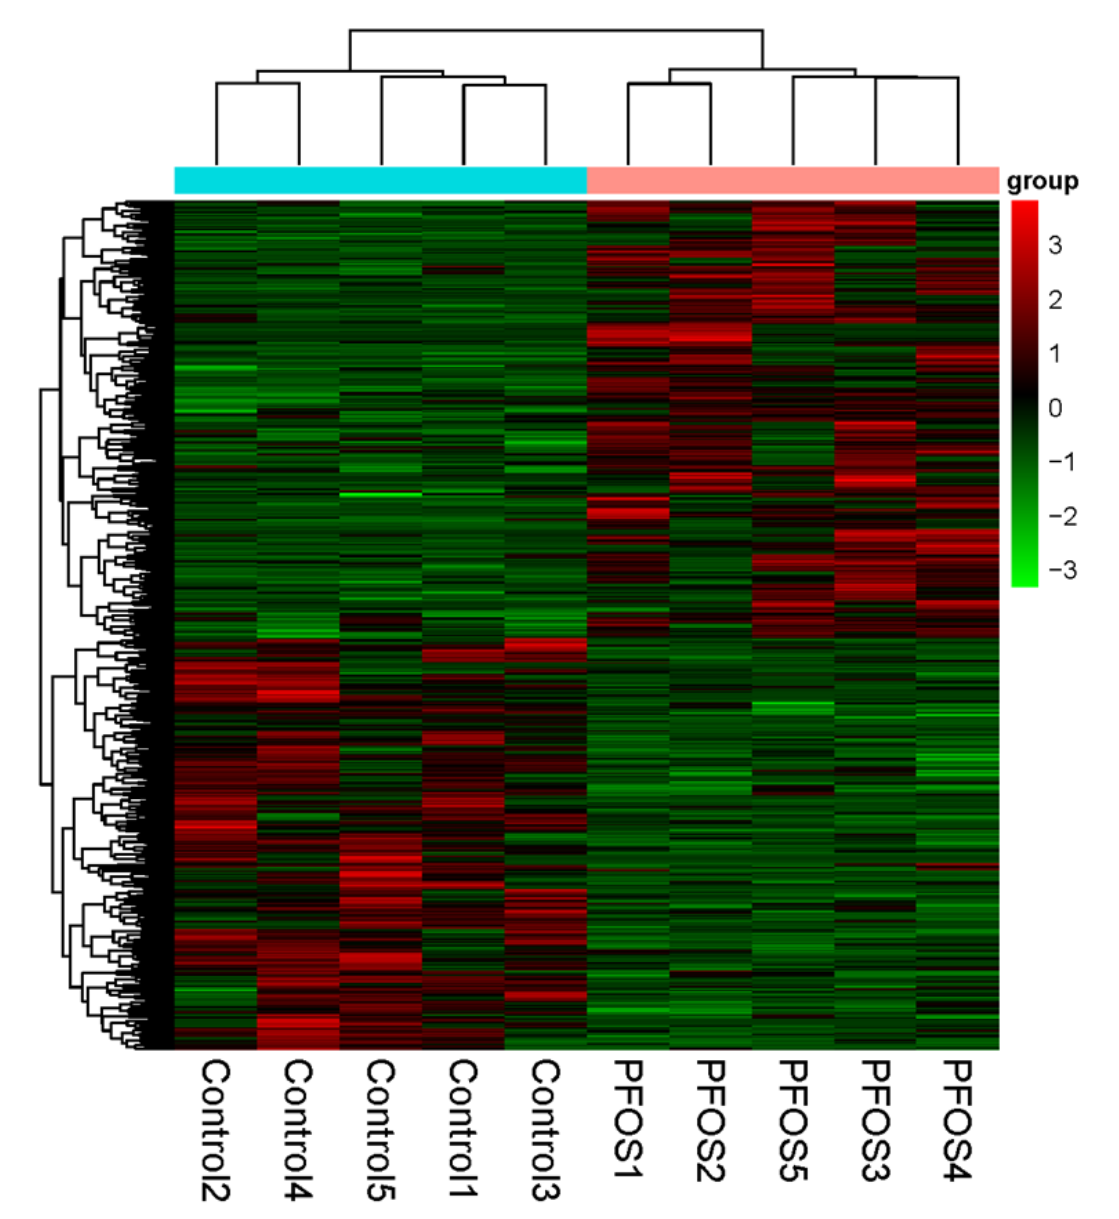
Figure 2. Hierarchical clustering for the differentially expressed genes between the PFOS (perfluorooctane sulfonic acid) and control. Red represents up-regulation and blue represents down-regulation. (For interpretation of the references to color in this figure legend, the reader is referred to the web version of this article).